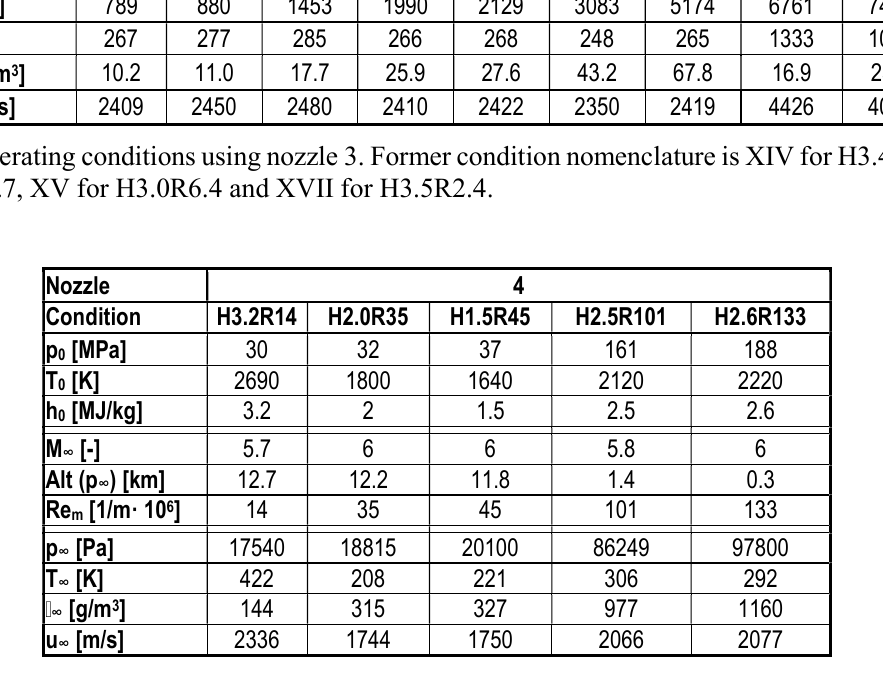
Table 3: Operating conditions using nozzle 4. Former condition nomenclature is XXI for H1.5R45 and XXII for